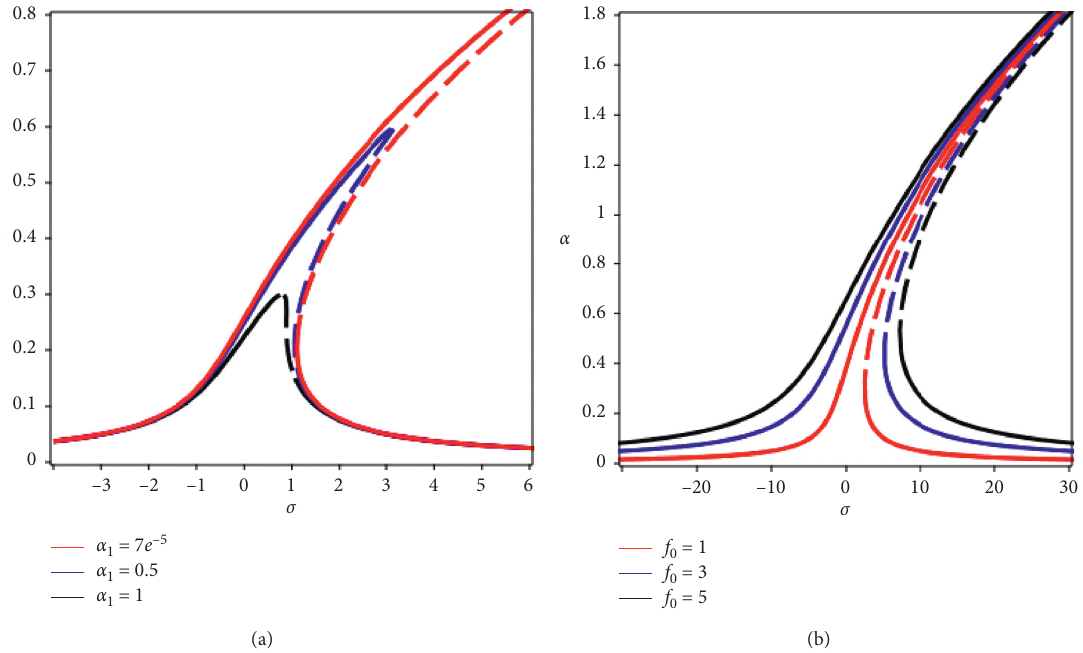
Figure 6: Frequency response for primary resonance. (a) Ω ≈ 1, α and broken lines are used for the loci of stable and unstable responses, respectively.